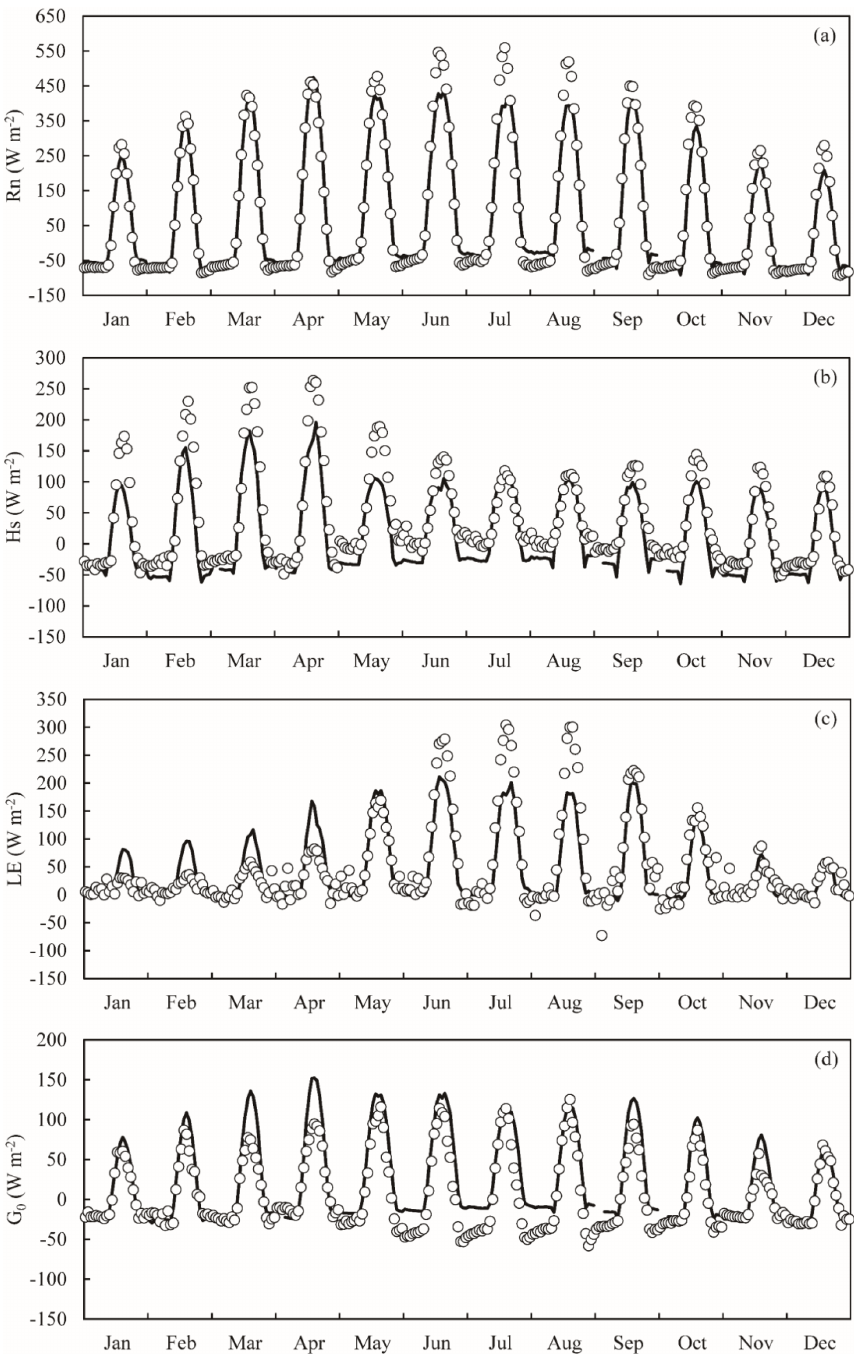
Figure 5. Time series of monthly mean diurnal change in surface energy fluxes (units: Wm − 2 ) observed by in situ measurements (circle), and those estimated by using the SEBS model (curve) at the BJ station in 2008 ( a shows net radiation flux, b shows sensible heat flux, c shows latent heat flux and d shows soil heat